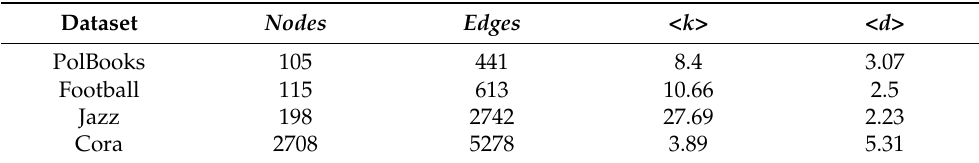
Table 1. Statistics of network datasets. Nodes and Edges represent the number of nodes and edges of the network, respectively, < k> indicates the average degree, and < d> denotes the average shortest path length of the